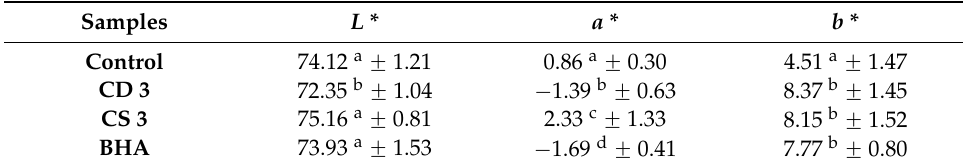
Table 4. Colour parameters of gelatine films: control, CD3 (1%), CS3 (0.2%) and BHA. Table 3. Colour parameters of gelatine films: control, CD3 (1%), CS3 (0.2%) and BHA. Samples